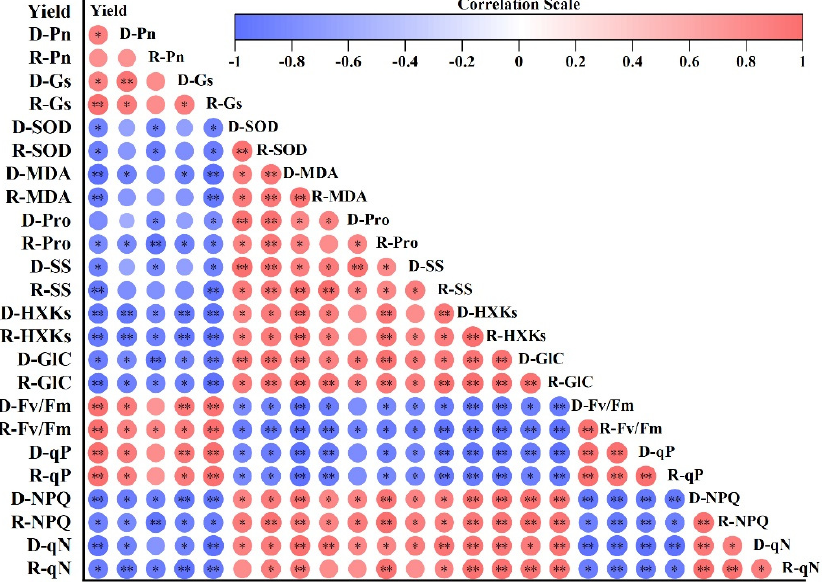
Table 3. Eigenvectors and rates of contribution of the principal components for each index.